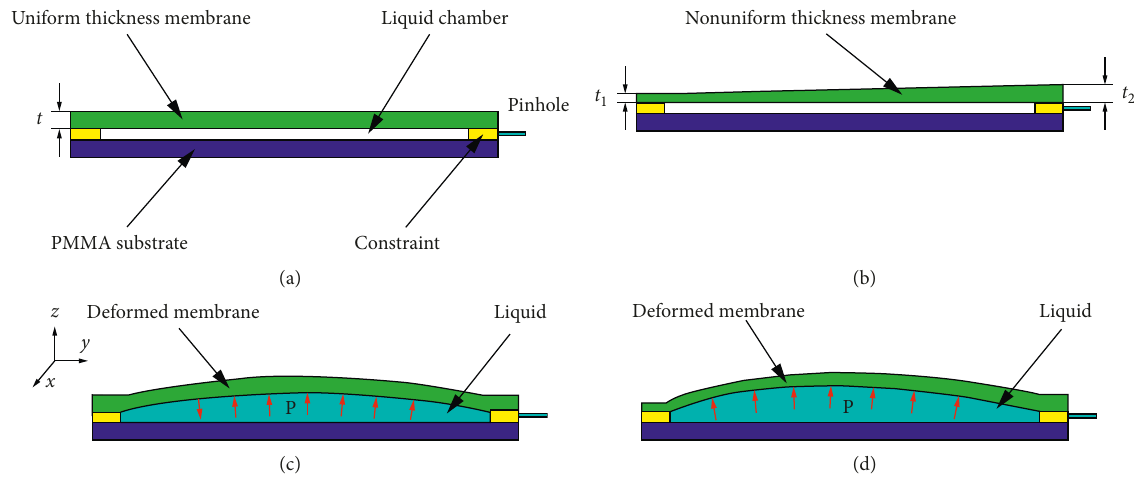
Figure 1: Schematic depiction of tunable liquid lenses. (a) Lens with a uniform thickness membrane before liquid injection. (b) Lens with a nonuniform thickness membrane before liquid injection. (c) Lens with uniform thickness deformed membrane after liquid injection. (d) Lens with a nonuniform thickness deformed membrane after liquid